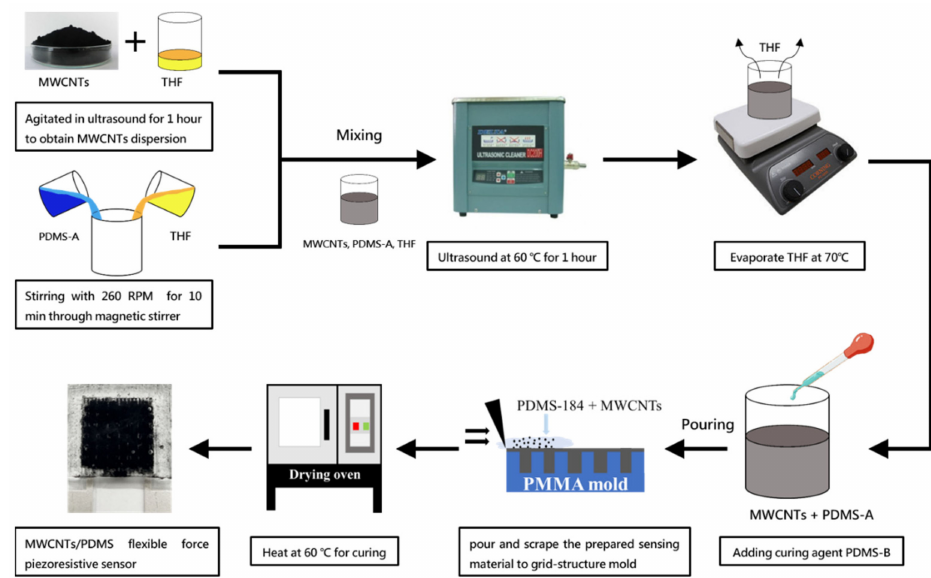
Figure 4. Schematic of the process flow diagram to fabricate the sensing material.